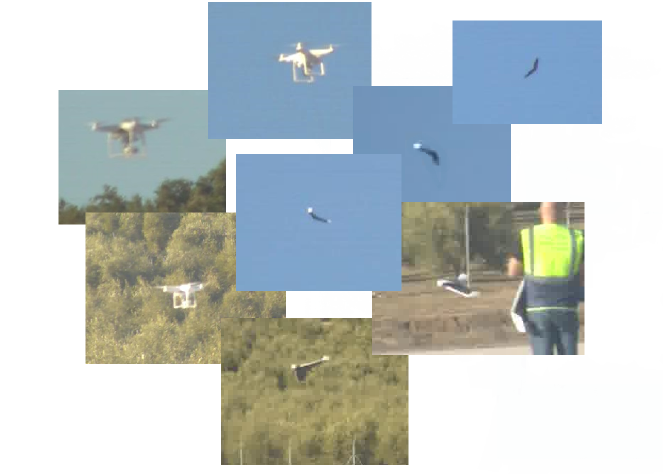
Figure 4. Images with rotary and fixed UAVs at different